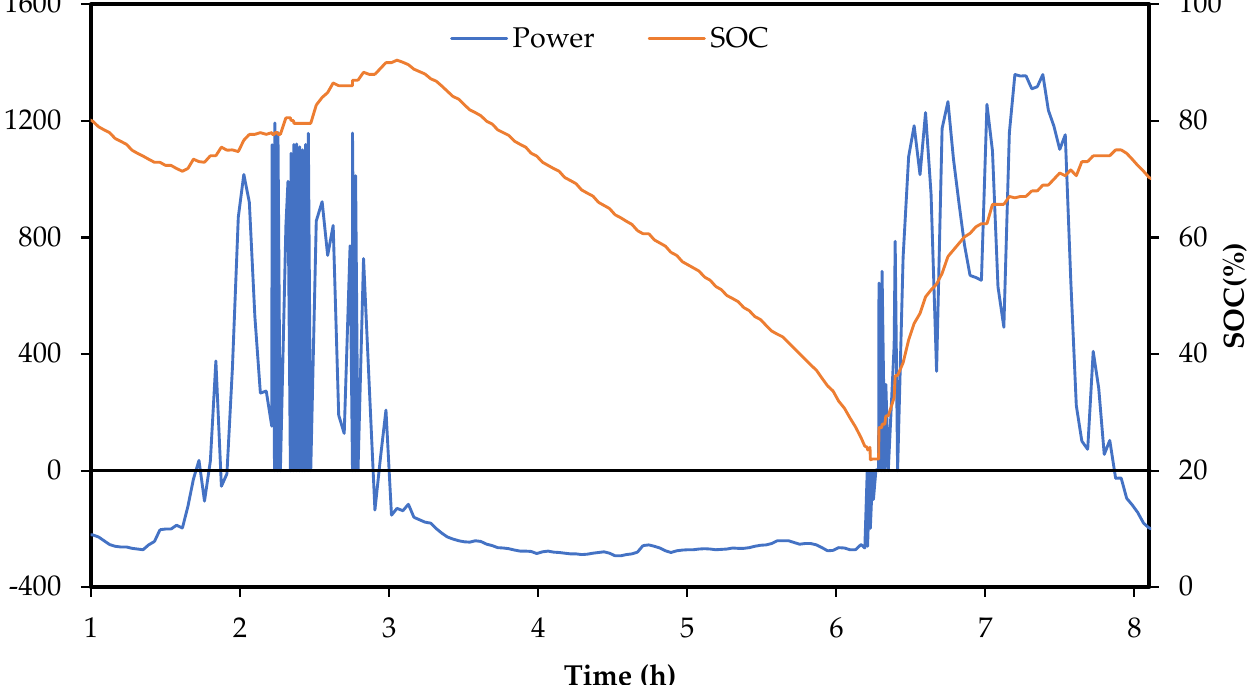
Figure 5. Comparative plot showing traded energy (%) in each charge/discharge cycle over a seven-day period for a VRFB with (electrolyte volume, S P and S T ) combinations of (35 L, ½ , ½ ), (40 L, ½ , ½ ) and (40 L, ½ , 1 / 3 ).